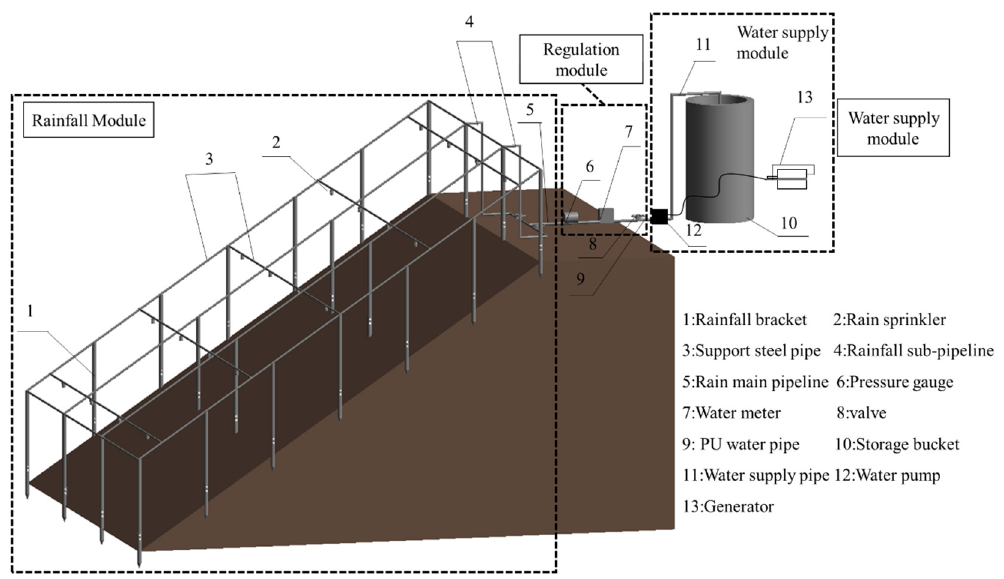
Figure 5. Schematic diagram of a convenient, efficient, and controllable high-speed railway slope artificial rainfall simulation system.